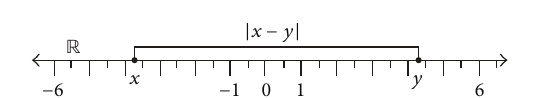
quantity is subtracted from another. An example is when the number 3 is subtracted from the number 6. The remainder is equivalent to − 3. The remainder is negative because 3 is less than